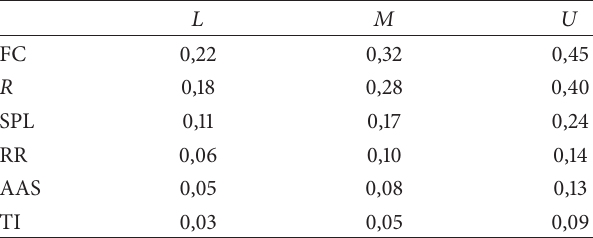
Table 8: Values of 𝑊 𝐶 .